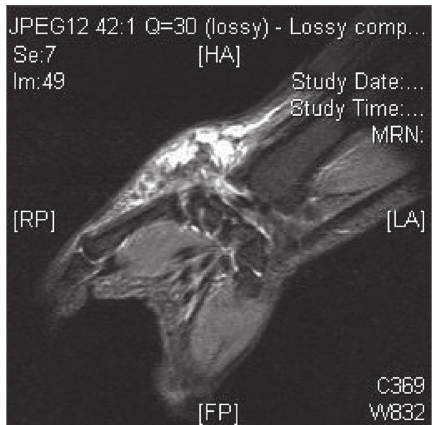
Figure 1: Magnetic resonance imaging (T2-weighted) of the left wrist.